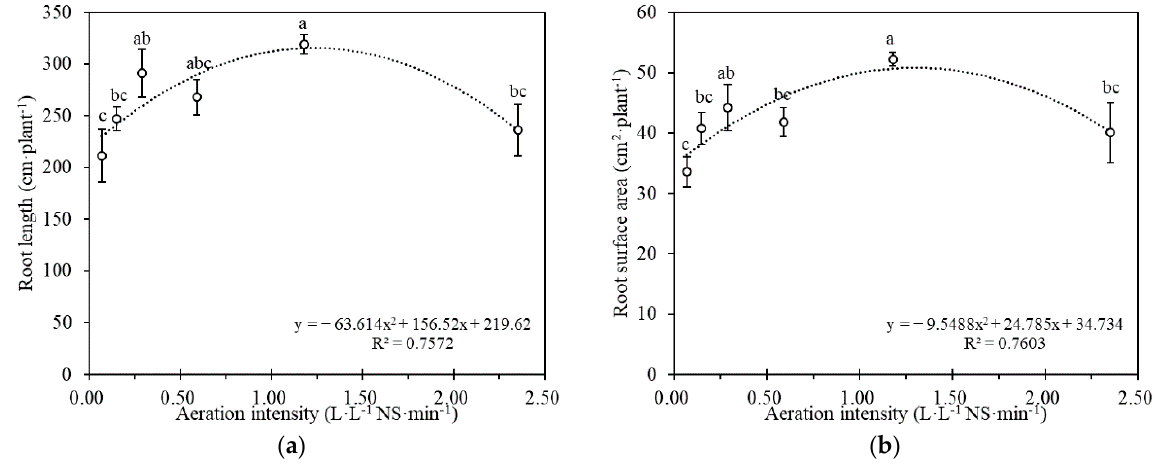
Figure 6. Root morphology under different aeration intensities. ( a ) Root length and ( b ) root surface area. Bars labeled with different letters indicate significant differences ( p ≤ 0.05); data are expressed as MSE ( n = 4).